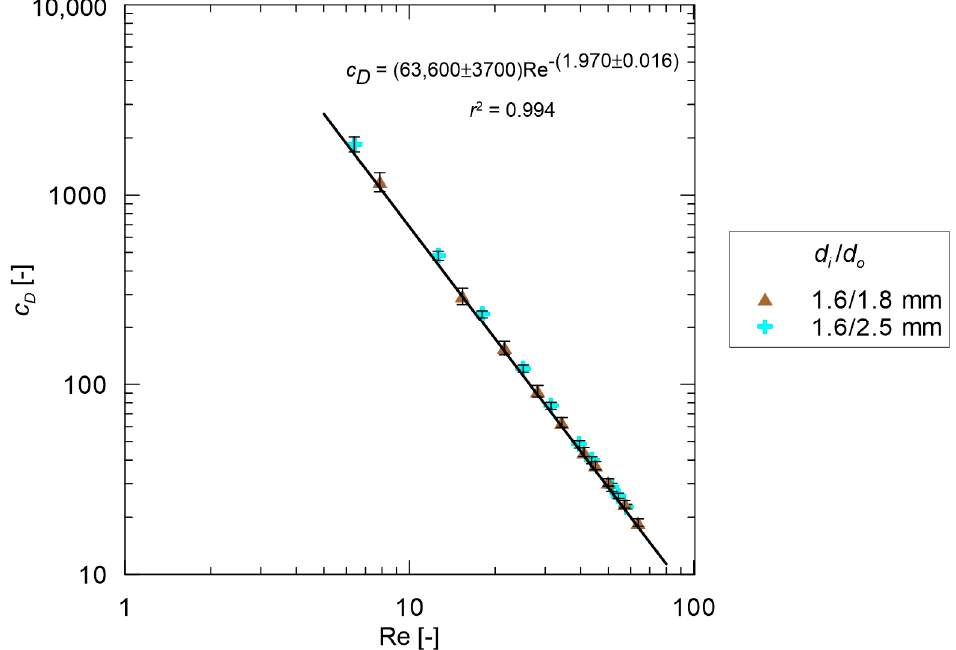
Figure 5. Drag coe ffi cient, c D , (28) versus Reynolds number (32) for two nozzles with identical inner diameter ( d i = 1.6 mm) and two di ff erent values of outer diameter ( d o = 1.8 mm and d o = 2.5